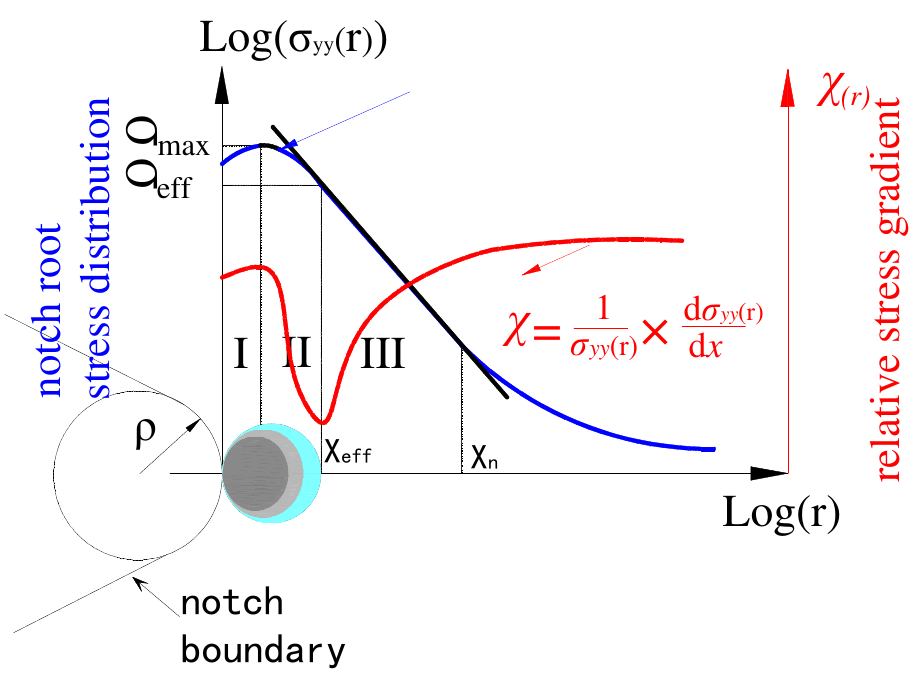
Figure 2. Schematic of elastic–plastic stress distribution along the notch ligament and the relative stress gradient concept.